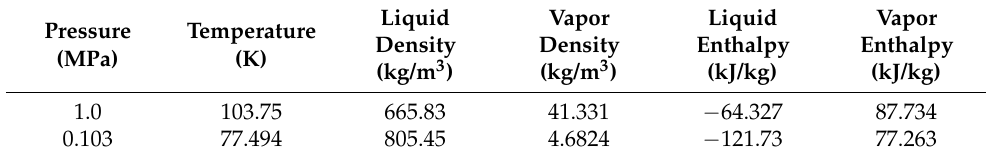
Table 2. Thermophysical properties of